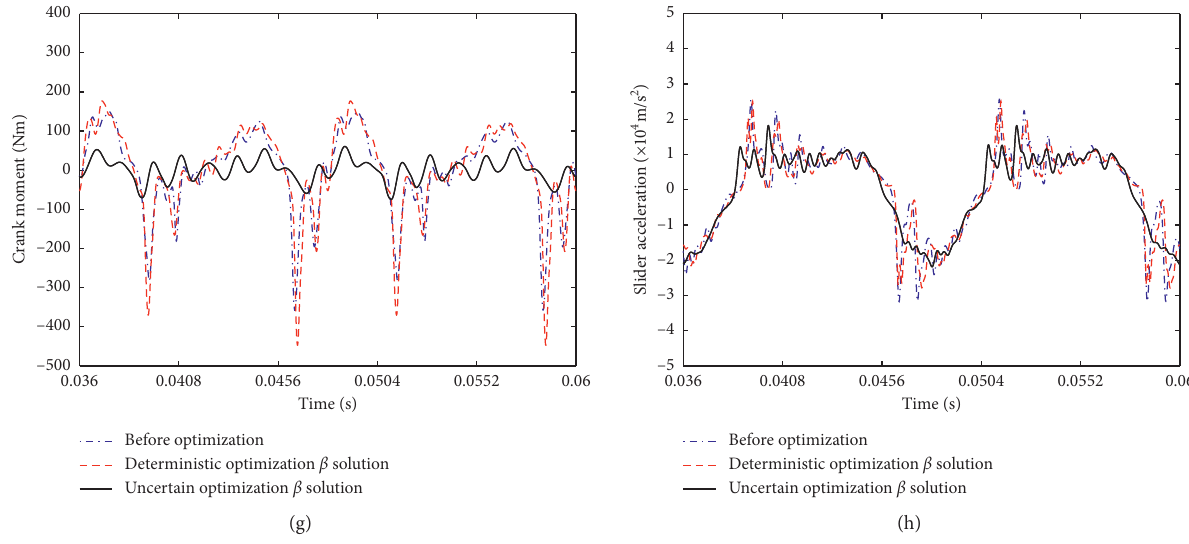
Figure 10: Comparison of the effects of deterministic optimization and uncertain optimization solutions on dynamic response of the